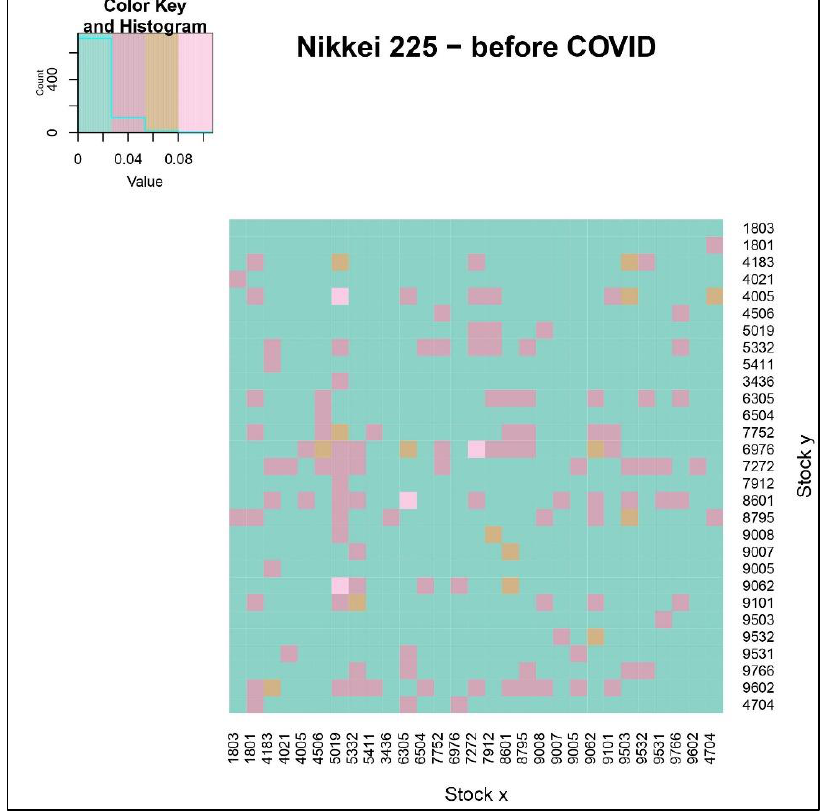
Figure 13. The information flow (effective transfer entropy) from stock y to stock x, for the top companies (by market capitalization) in the Nikkei market, before the COVID-19 outbreak